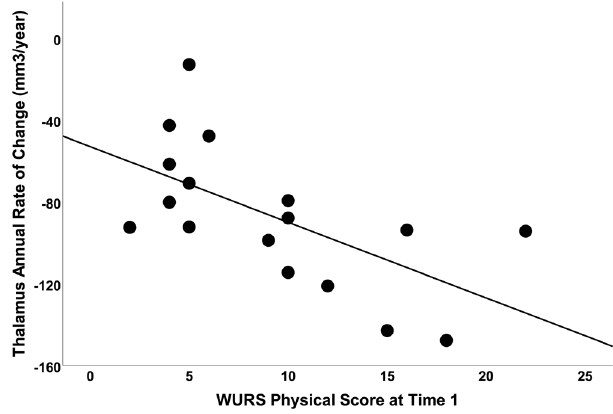
Figure 5. Correlation between percent change in thalamic volume and WURS physical score in Wolfram participants. Greater physical symptom severity (higher WURS score) at enrollment was associated with greater negative change in thalamic volume over time (r s = − 0.669, p = 0.003, n =